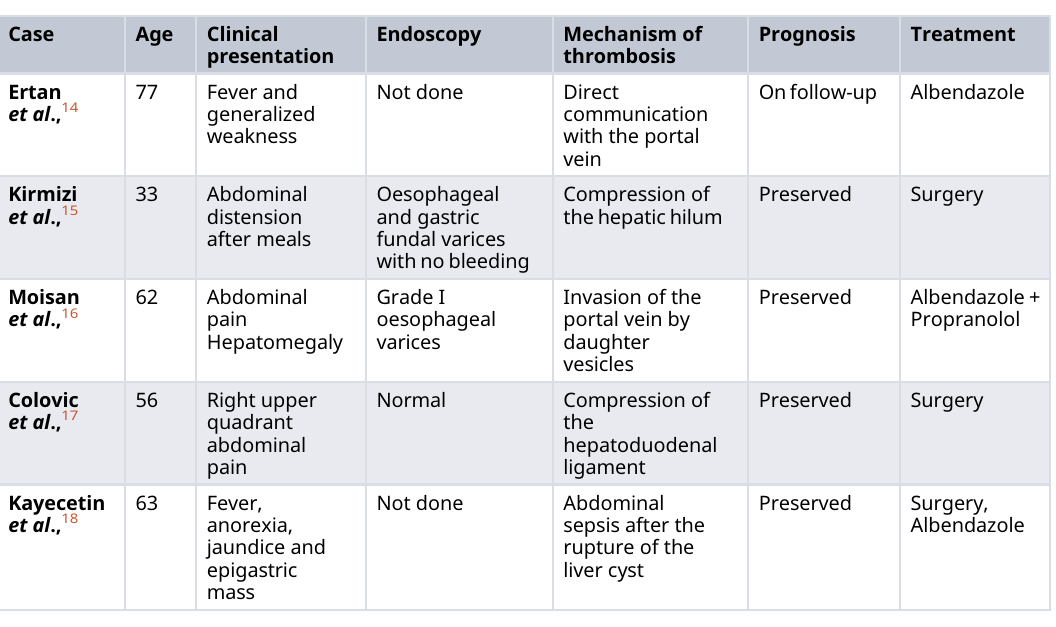
Table 2. Cases of hepatic hydatid cyst causing portal